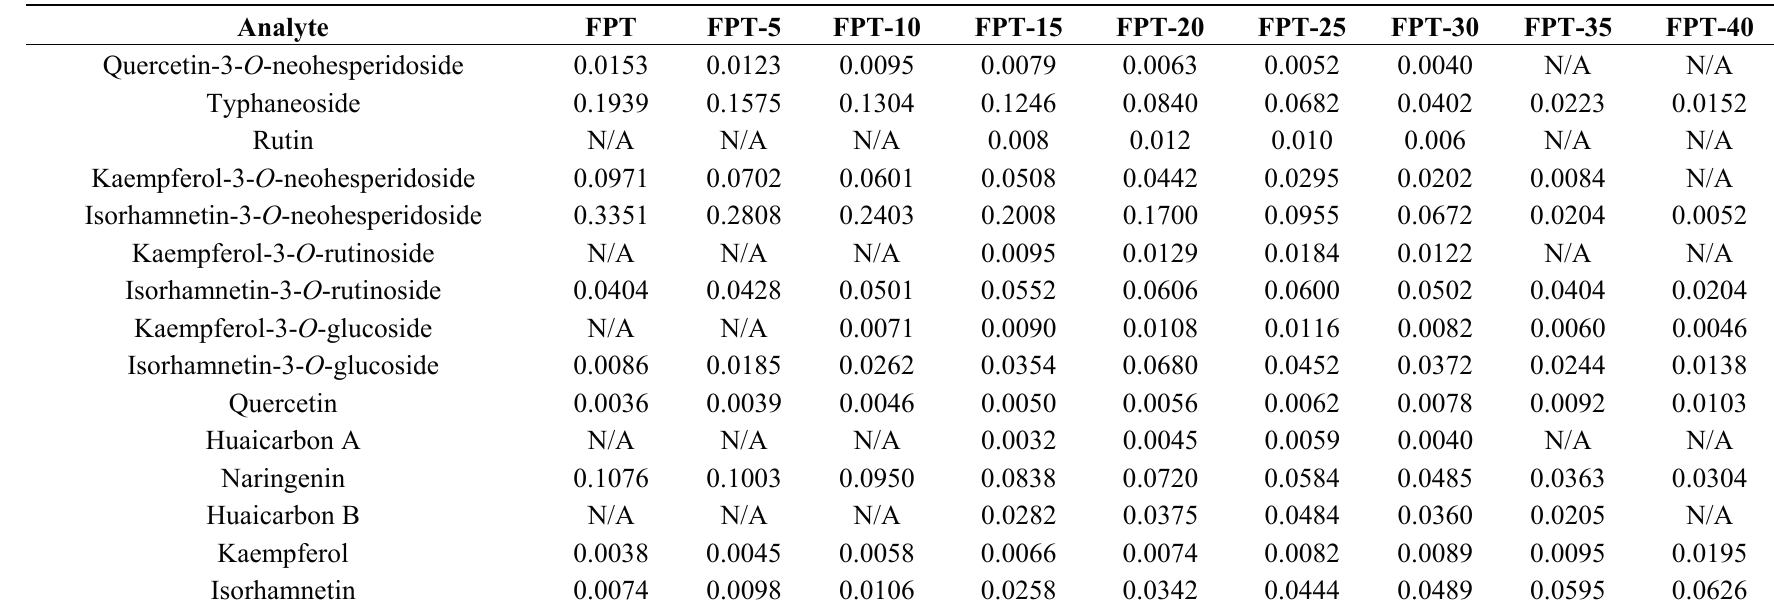
Table 5. Contents of the 15 analytes in samples of FPT-N